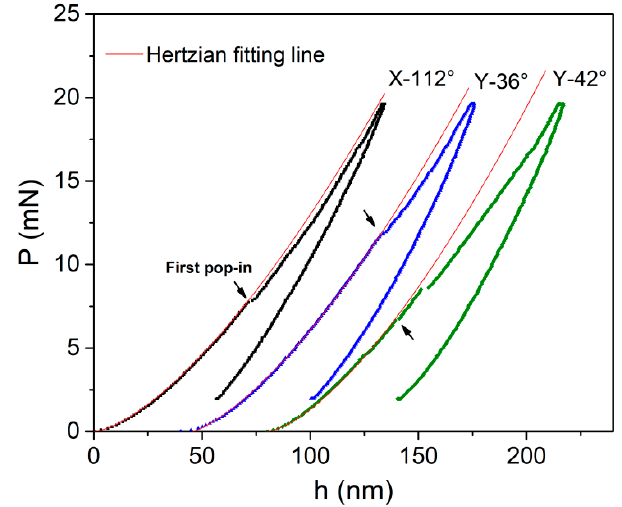
Figure 1. Typical load versus displacement ( P–h ) curves of X-112°, Y-36°, and Y-42° planes under spherical nanoindentation; the initial loading segment could be perfectly fitted by Hertzian contact theory. The first pop-in event currently occurred at the position of deviation point between Hertzian fitting line and loading sequence.